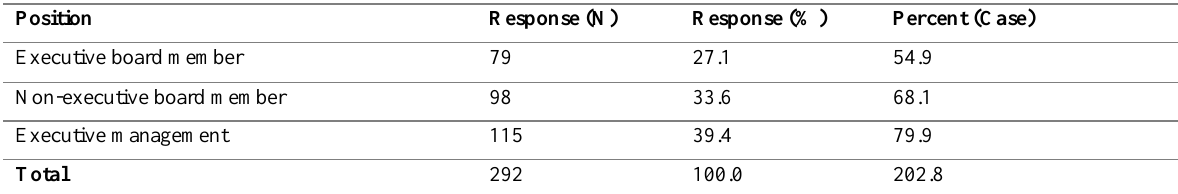
Table 1: Respondent’s Organisational Position